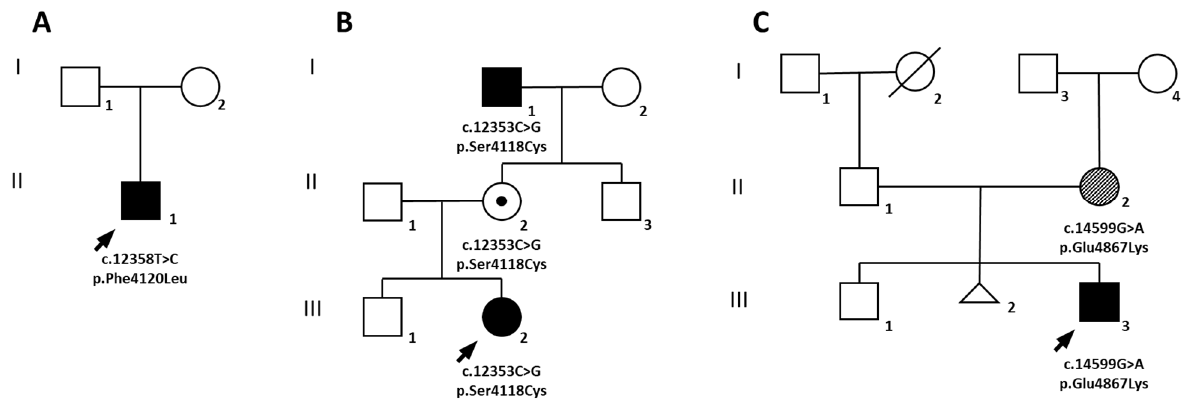
Figure 1. Pedigree of families A , B and C with variants in RNF213. Probands are indicated by an arrow. A black symbol identifies subjects with bilateral moyamoya, a dot indicates an obligate carrier, while a diagonal pattern fill highlights other vascular manifestations. Generations are reported in roman numbers.